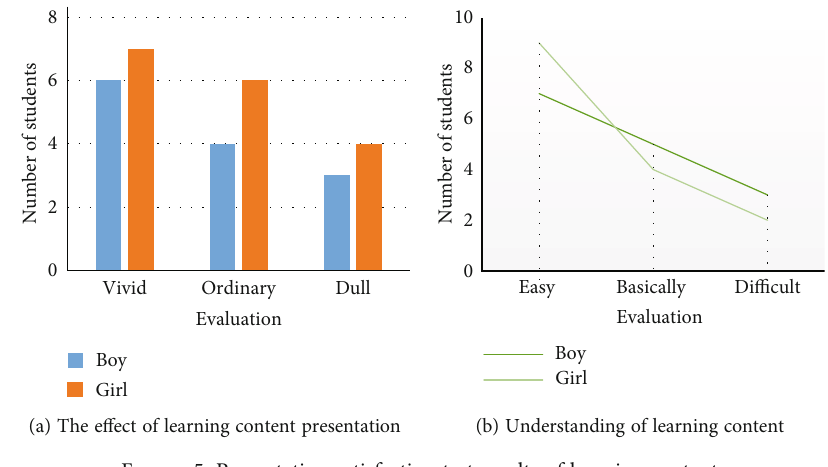
Figure 5: Presentation satisfaction test results of learning content.